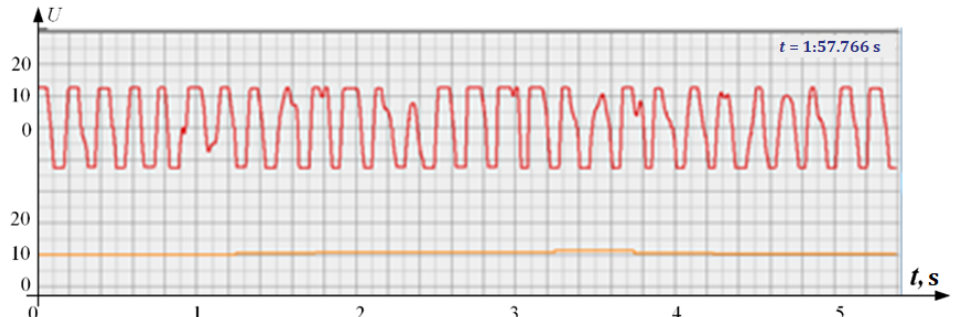
8 of 17 Figure 5. Ultrasonic signal (USS) conversion after filtering and amplification-red diagram. Heart